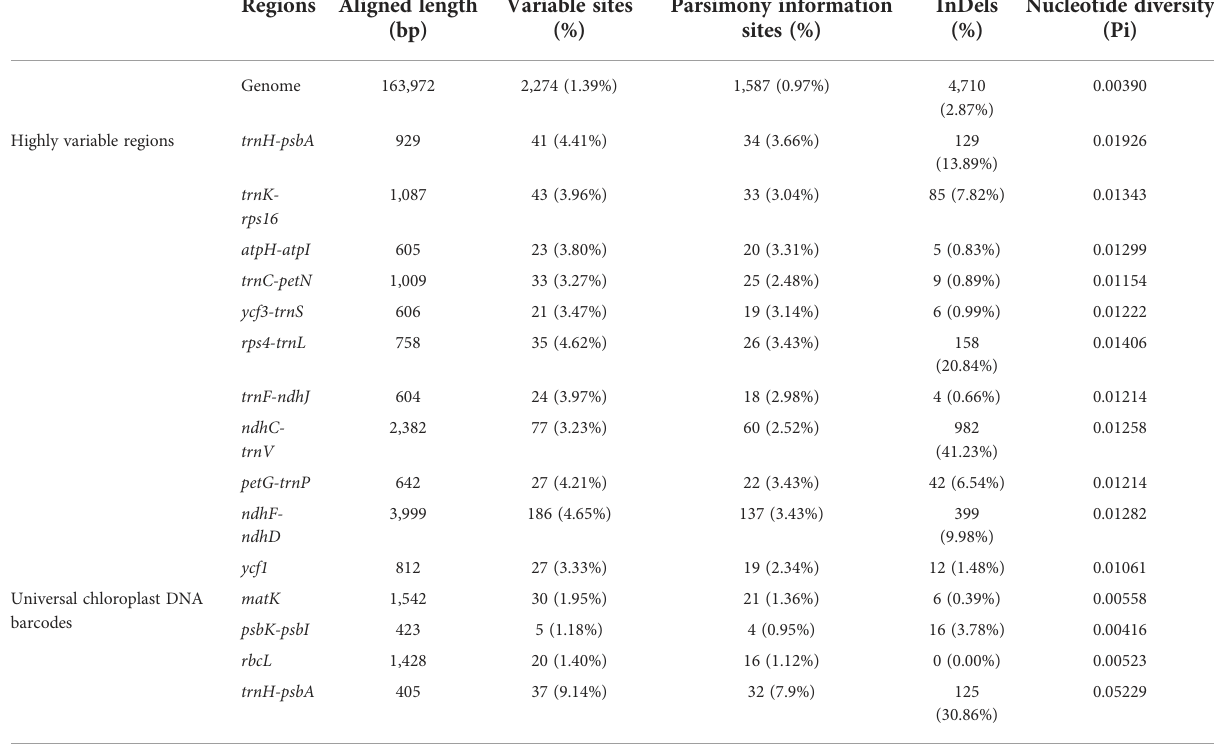
TABLE 5 Characteristics of the chloroplast genome and highly variable regions of Sabia .